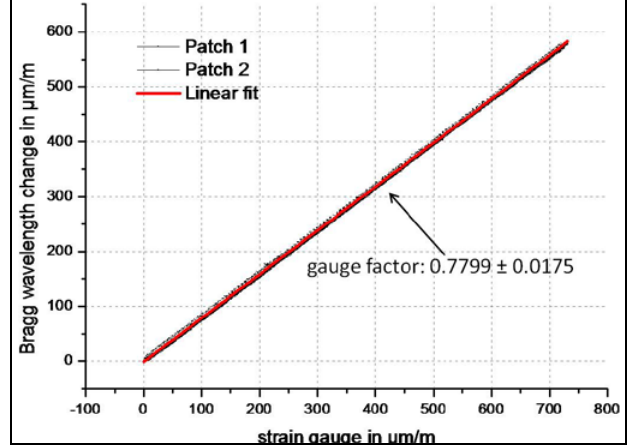
Figure 8. Determination of the strain gauge factor from the change in Bragg wavelength compared to resistance strain gauges.